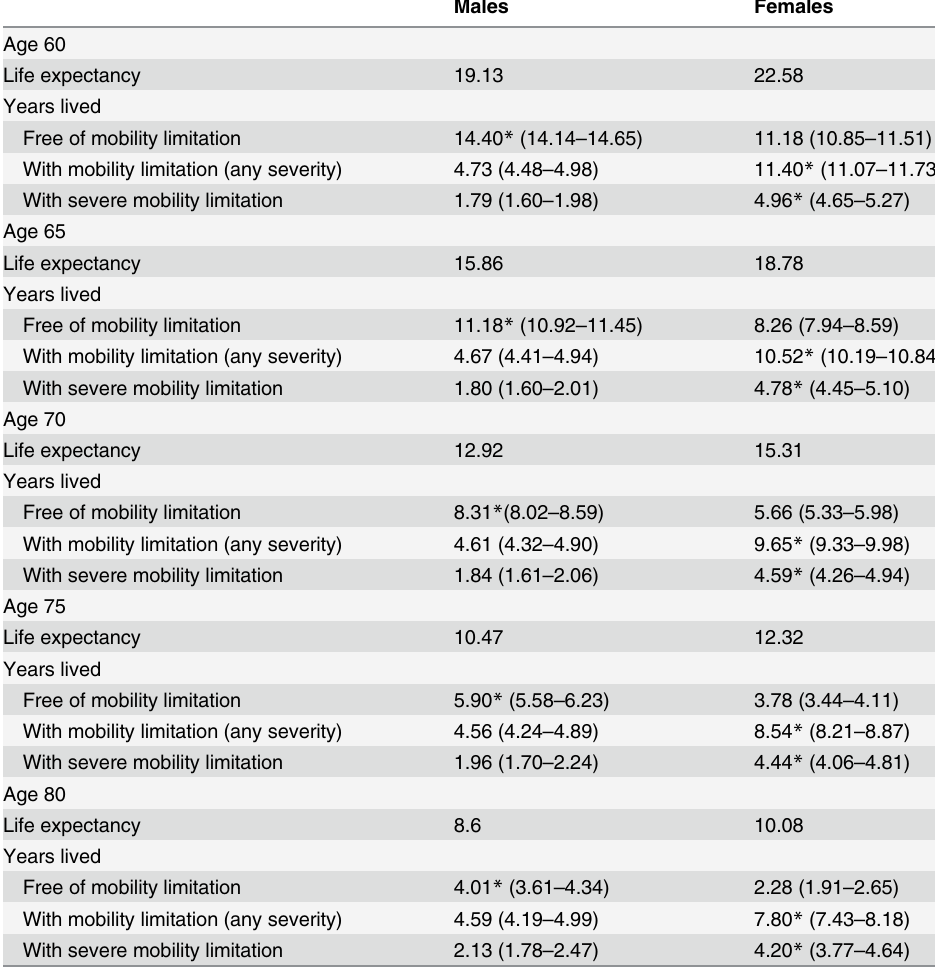
Table 3. Life expectancy and number of years lived in different states of mobility limitation at age 60, 65, 70, 75, and 80 by genders in Thailand,